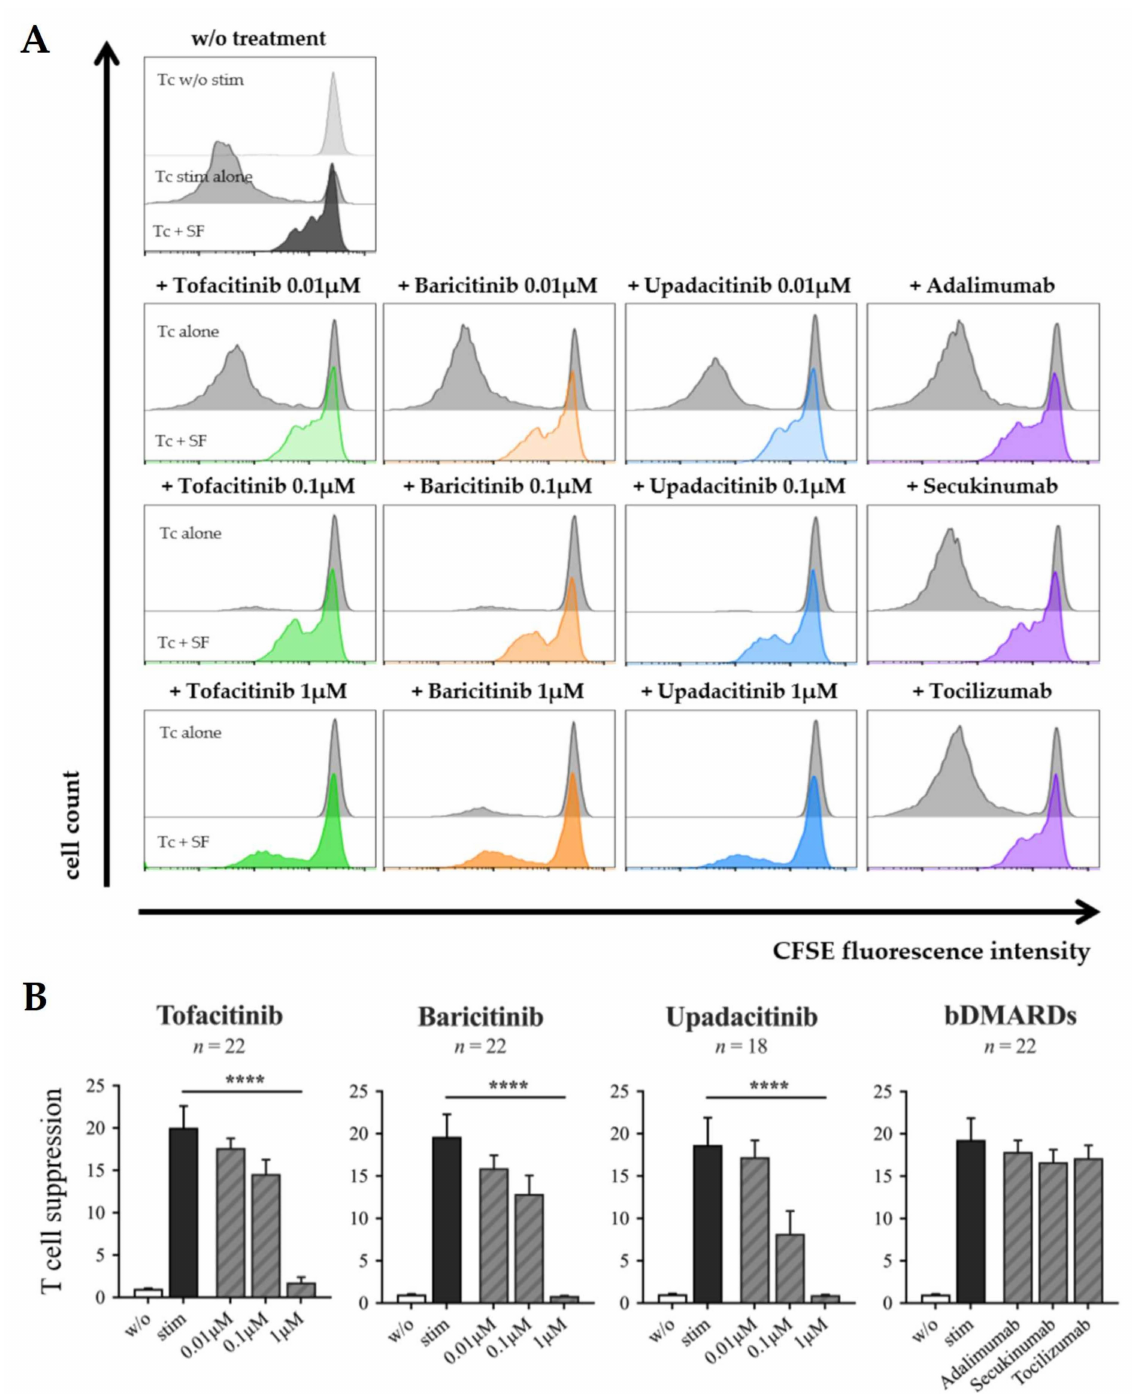
Figure 7. Effects of tofacitinib, baricitinib, upadacitinib and bDMARDs on the suppression of Th cell-proliferation by SF. CFSE-labeled Th cells were cultured alone or in co-culture with SF (OASF ( n = 10–12), RASF ( n = 8–10)) in the presence or absence of anti-CD3/ anti-CD28 and drugs as indicated. Cells were harvested on day 6 and T cell-proliferation was determined by flow cytometry. ( A ) Histograms from one representative experiment. ( B ) Suppression of Th cell-proliferation as detected in all experiments. T cell suppression was calculated by dividing the CFSE median fluorescence intensity (MFI) of Th cells co-cultured with SF by those of Th cells cultured alone. Data shown as mean ± SEM, significance tested using Wilcoxon signed-rank test, p **** ≤